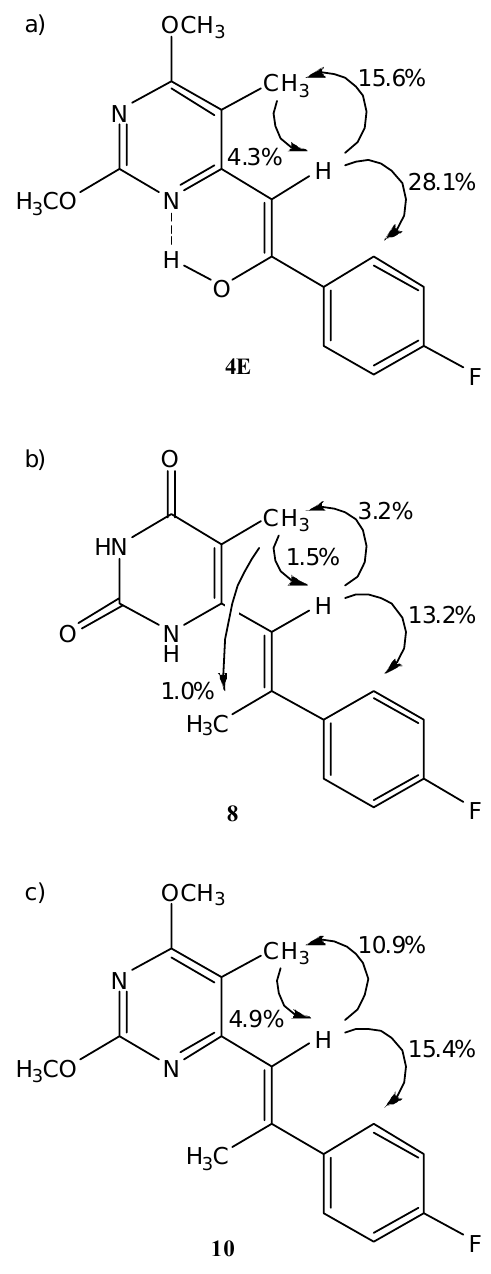
Figure 3. The key NOE enhancements and configuration along C1'=C2' double bond for a) 4E , b) 8 and c) 10 in DMSO- d 6